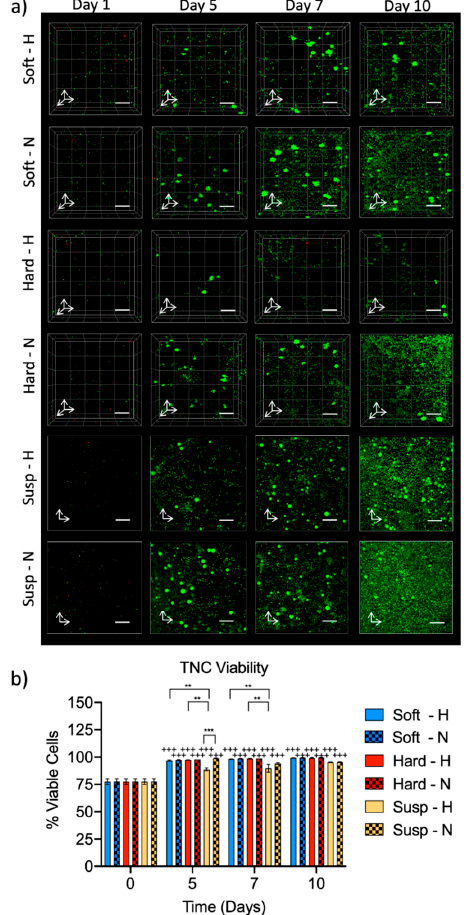
Figure 3. Fibrin hydrogels support the viability of Lin − / cKit + cells: ( a ) confocal images of live (green) and dead (red) cells in soft and hard fibrin hydrogels as well as in suspension culture (Susp) grown in hypoxia (H) or normoxia (N) and ( b ) quantification of viability of Lin − /cKit + progeny using the NucleoCounter ® . Day 0 values are from the starting cell suspension. Scale bars are 200 μ m, and white arrows indicate x- and y-axes for 2D images or x-, y-, and z-axes for 3D image stacks. Data were obtained from 2 biological replicates and are represented as mean ± S.E.M. Statistical analysis was performed with a three-way ANOVA followed by Tukey post hoc tests for multiple comparisons. The plus signs denote significance between data collected at different time points against day 0: +++ p < 0.001. Other significant differences between groups are indicated with ** p < 0.01 and *** p < 0.001.